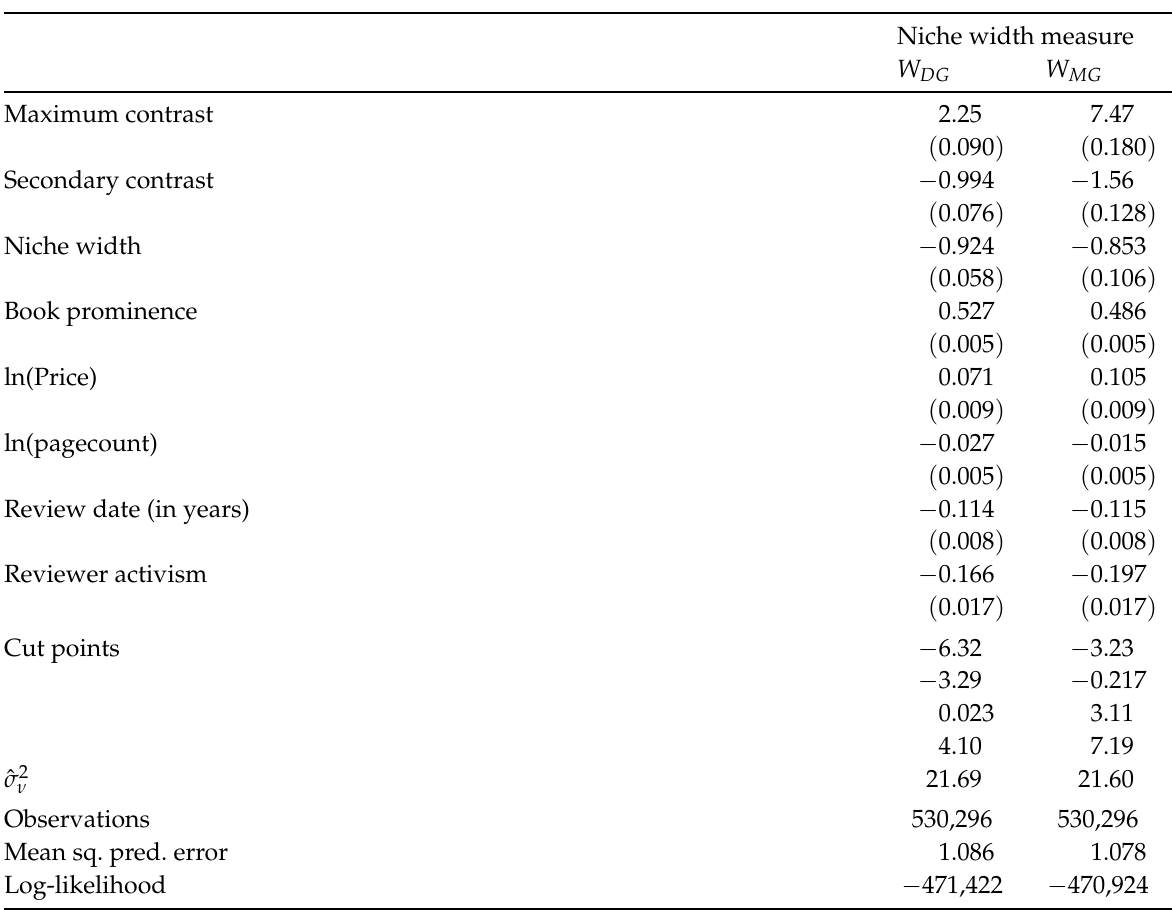
Table 5: Effects of categorical contrast and niche width on the appeal of books: ML estimates of